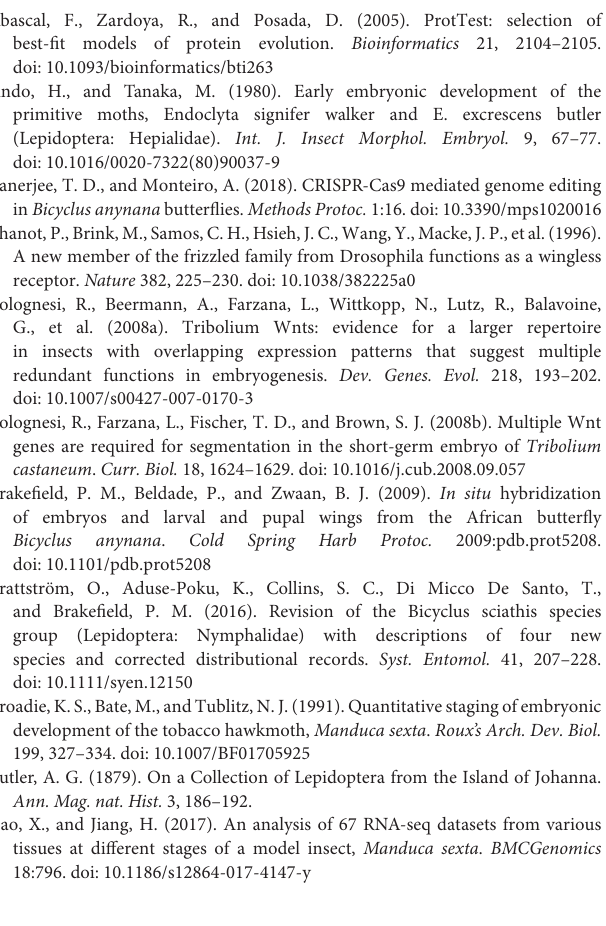
Supplement Figure S2 | Embryos stained with Wnt5 , Wnt6 and Wnt9 probes. No expression was observed in the stages assayed. (A-C) Embryos stained for